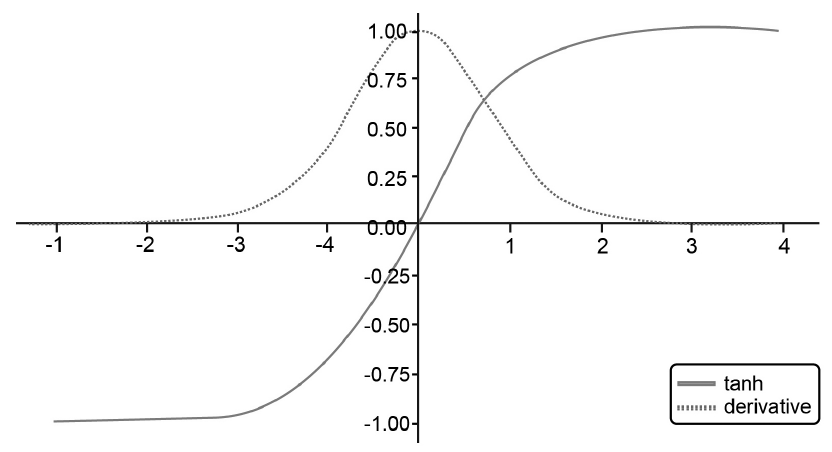
Figure 2. Tanh and its derivative [42].